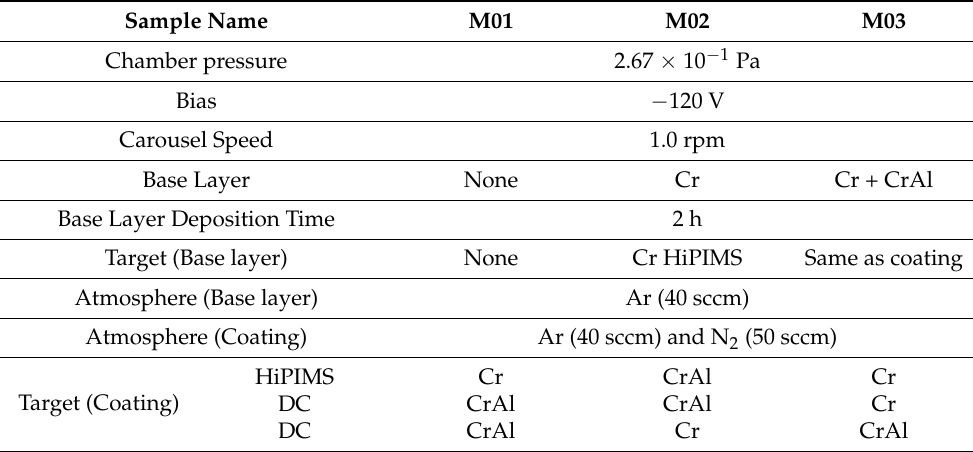
Table 1. The main deposition parameters for the different coating strategies.